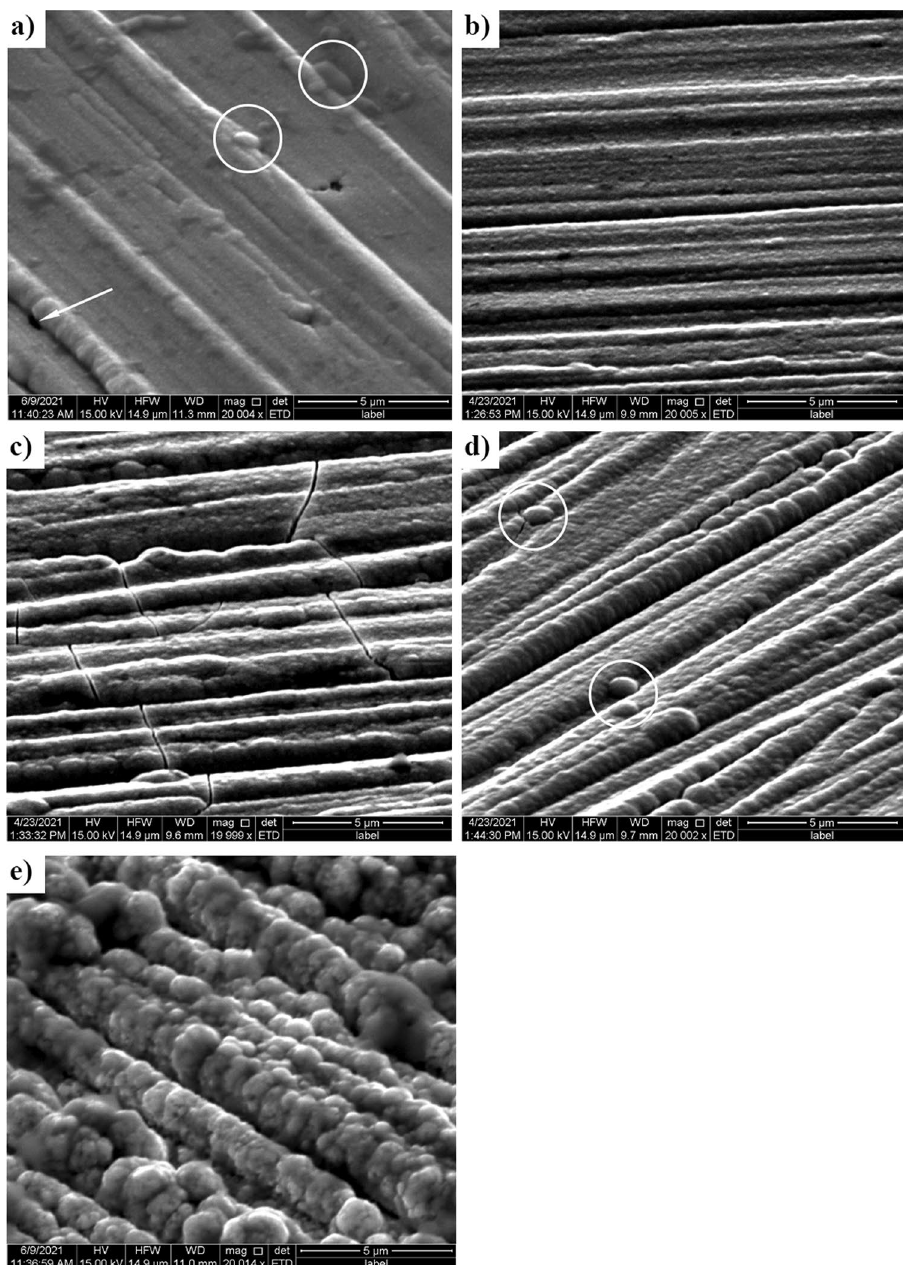
Figure 3. Electron microscope micrographs of the Ni–Mo alloy coatings deposited from DES + 0.2 mol dm